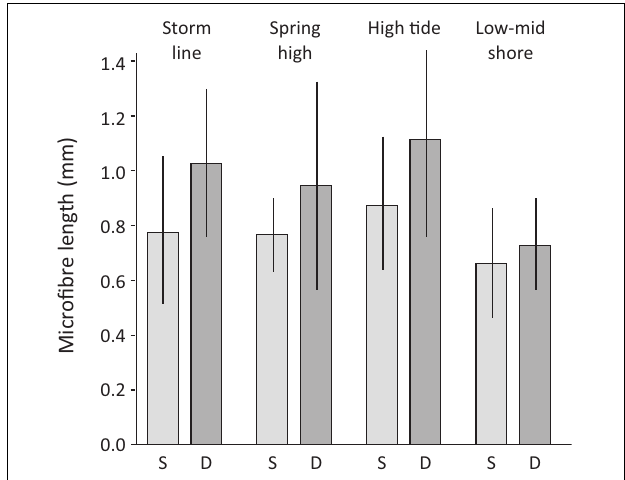
FIGURE 3 | The mean length of microfibers from surface (S, 0–12 cm) and deep (D, 12–24 cm) cores collected at three sites on a beach in the West Coast National Park, South Africa, in 2017. Bars show 95% confidence intervals of the mean.